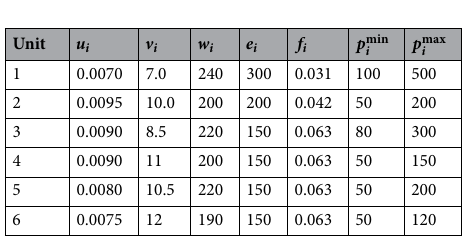
Figure 12. ABWO performance for case study-III.